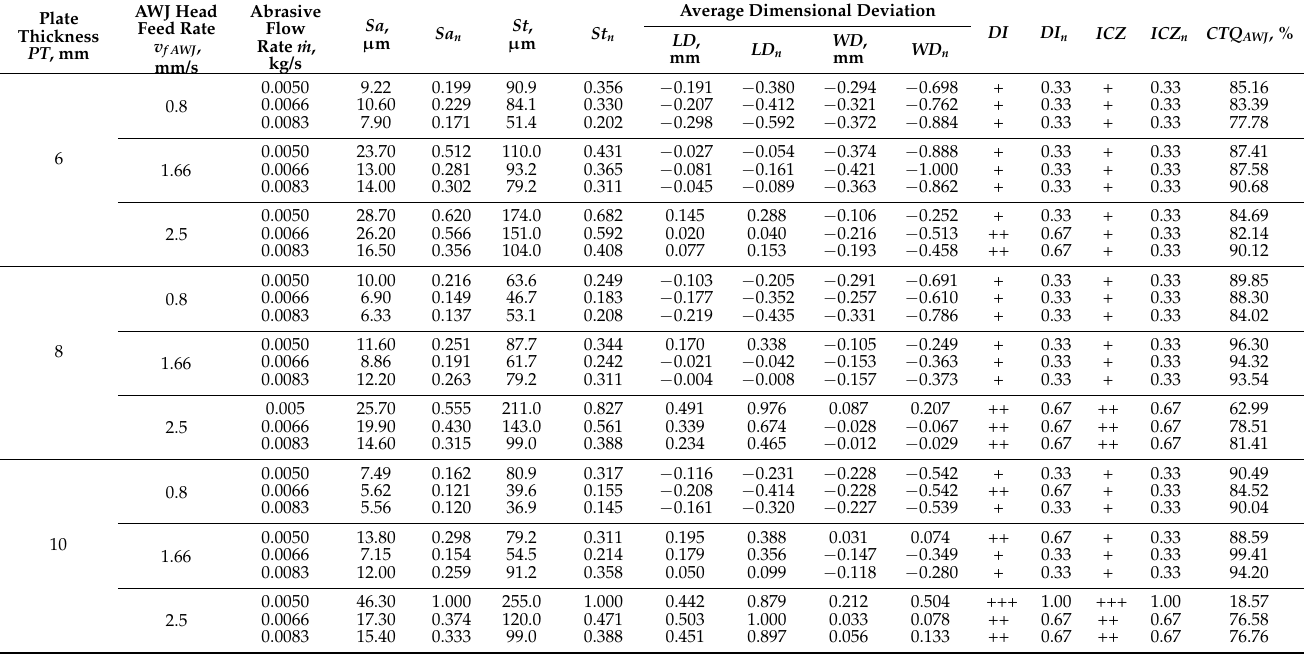
Table 5. List of the values of factors (before and after normalization) enabling the determination of cutting technological quality index after AWJ cutting CTQ AWJ (subscripts n denote values after